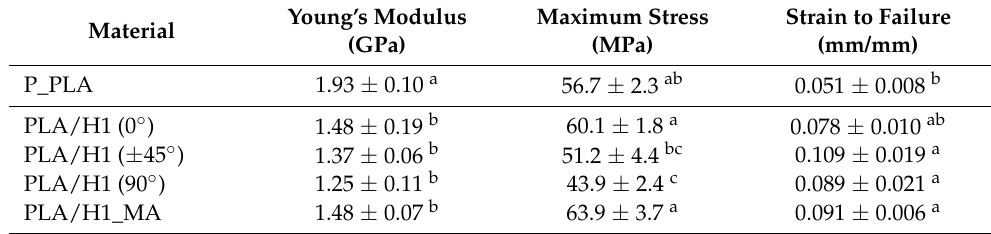
Figure 9. Average tensile stress–strain curves of 3D printed P_PLA and PLA/H1_MA specimens, and PLA/H1 specimens printed with raster angles of 0°, ±45°, and 90°. Table 5. Tensile mechanical properties of 3D printed P_PLA and PLA/H1_MA specimens, and PLA/H1 specimens printed with raster angles of 0°, ±45°, and 90°.